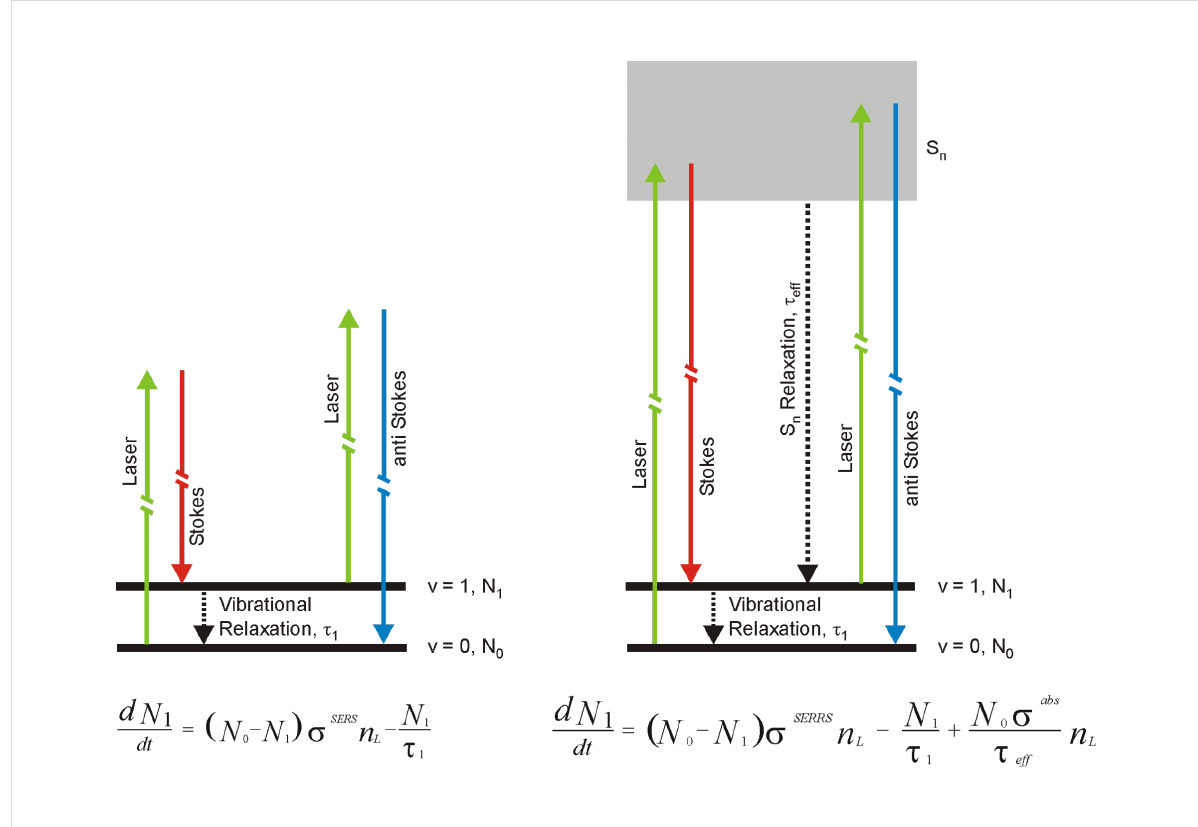
Figure 3: Non-resonant (left) and resonant (right) Stokes and anti-Stokes Raman scattering in an energy level diagram. The rate equations describe the population of the first excited vibrational level. N 1 and N 0 are the numbers of molecules in the excited and ground vibrational state, respectively. σ SERS and σ SERRS are effective SERS and SERRS cross sections, respectively, σ abs describes electronic absorption. τ 1 is the lifetime of the first excited vibrational state, τ eff the inverse rate constant for the population of the first excited vibrational level by internal conversion followed by vibra- tional relaxation and/or by fluorescence. n L is the number of laser photons per cm 2 and second applied for the